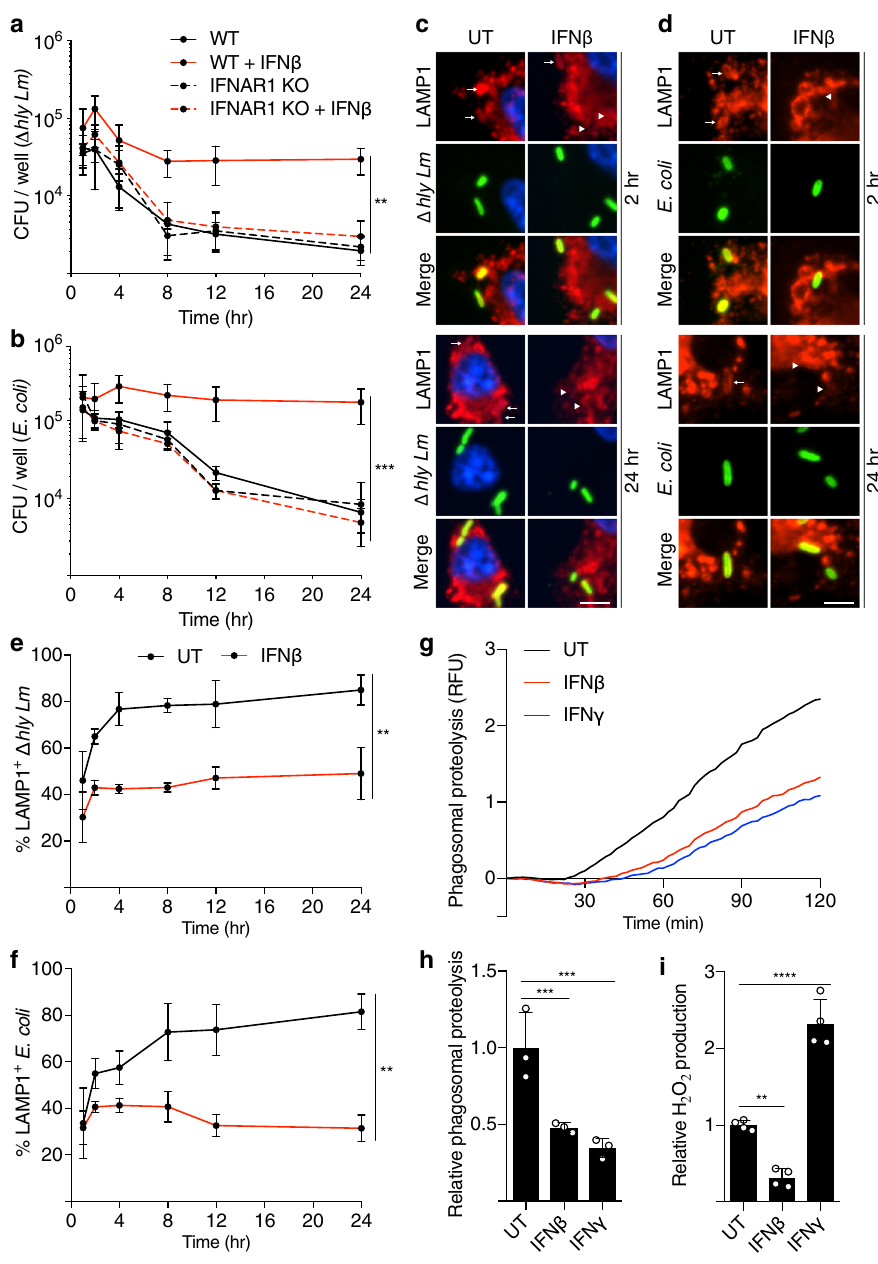
Fig. 1 Type I IFN suppresses antibacterial activity in phagosomes. Time course of bacteria killing over 24 h of ( a ) Δ hly Lm or ( b ) E. coli infected WT and IFNAR1 KO BMDMs with or without IFN β pretreatment. ** P = 0.0012, *** P = 0.001. Representative images ( c , d ) and quanti fi cation ( e , f ) of LAMP1- positive bacteria in BMDMs treated with or without IFN β , infected with Δ hly Lm ( c , e ) or E. coli ( d , f ) over 24 h. ** P < 0.0087. Arrow denotes LAMP1- positive bacteria, arrowhead denotes LAMP1-negative bacteria. Bulk proteolysis over time ( g ) and slope of the curve ’ s linear portion ( h ) of DQ-BSA-labeled particles in untreated (UT) phagosomes, or treated with IFN β or IFN γ . *** P < 0.0009. RFU relative fl uorescence unit. i Measurement of ROS production in phagosomes of zymosan-fed BMDMs with and without IFN β or IFN γ . ** P = 0.0042, **** P < 0.0001. Data shown are means ± standard deviation (s.d.) for at least n = 3 independent experiments. P value was calculated using ( a , b ) two-way analysis of variance (ANOVA) and ( e , f , h , i ) one-way ANOVA. Scale bars, 3 µ